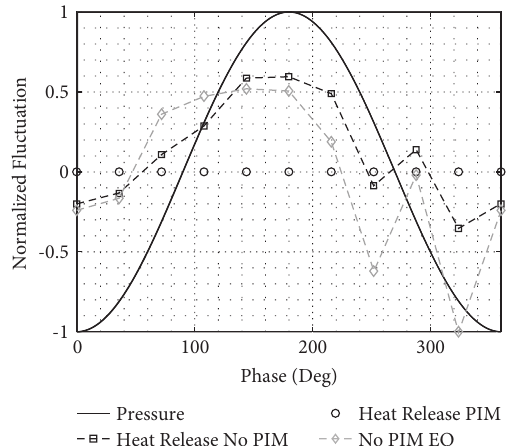
Figure 20: No PIM and PIM heat release summation results compared to acoustic pressure and no PIM equivalence variation with